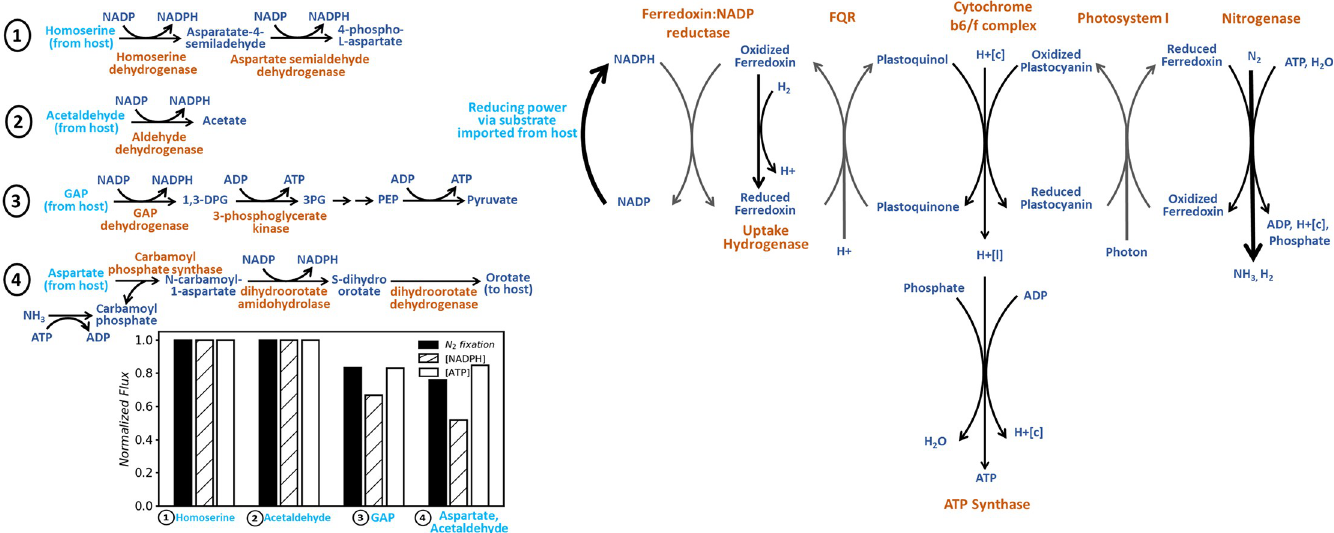
Fig 3. Nitrogen fixation in UCYN-A. Reactions associated with nitrogen fixation in UCYN-A and the facilitating substrates imported from the host. Substrates (shown in cyan) have been ranked in order of their N 2 -fixation yield (mmol N 2 fixed/mmol CO 2 uptake). The bar chart shows nitrogen fixation, total ATP yield, and total NADPH yield flux for four alternative substrates, normalized by the maximal value observed across substrates. Metabolites are shown in blue and enzymes in orange in the pathway diagram (right).